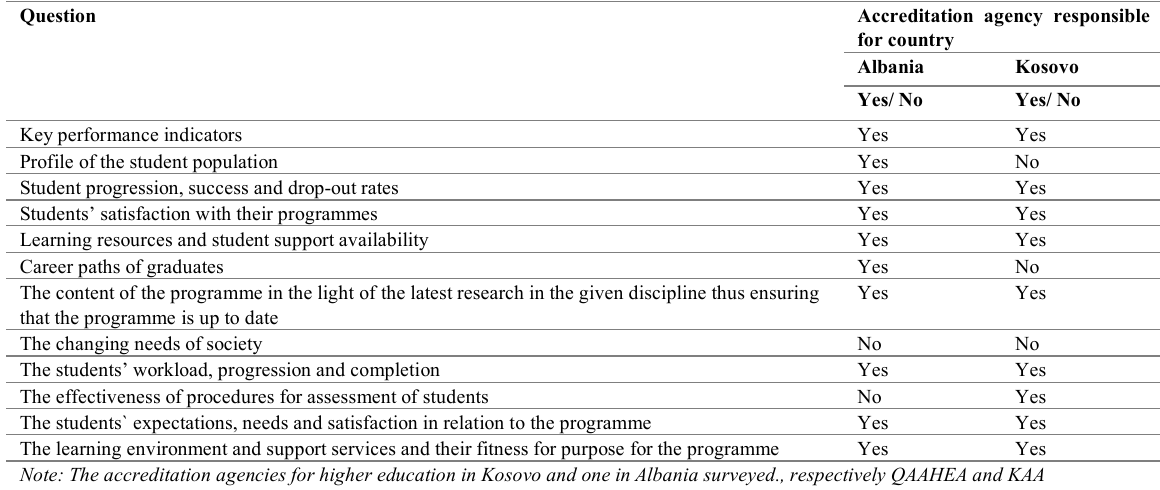
Table 16 : Internal quality assurance: Information (KAA and QAAHE)